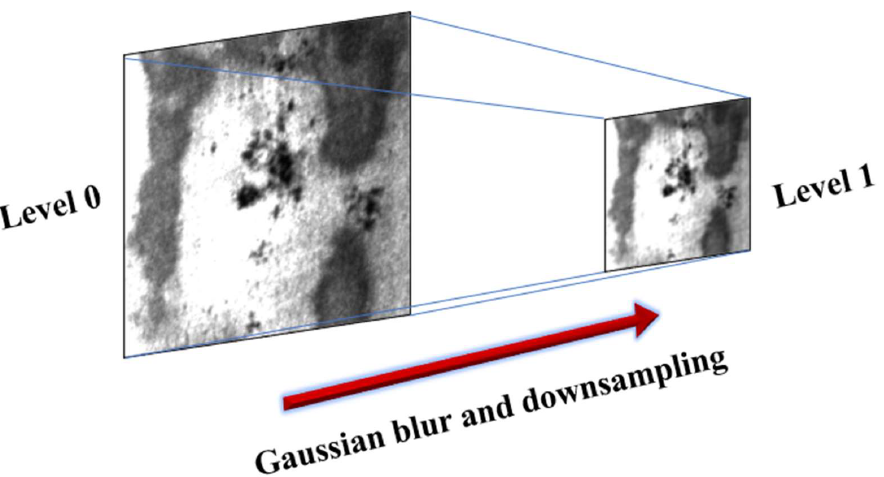
Figure 1. The results of the Gaussian pyramid. Level 0 represents the raw image and level 1 represent the downsampled image, which contains only half of the level 0 resolution.